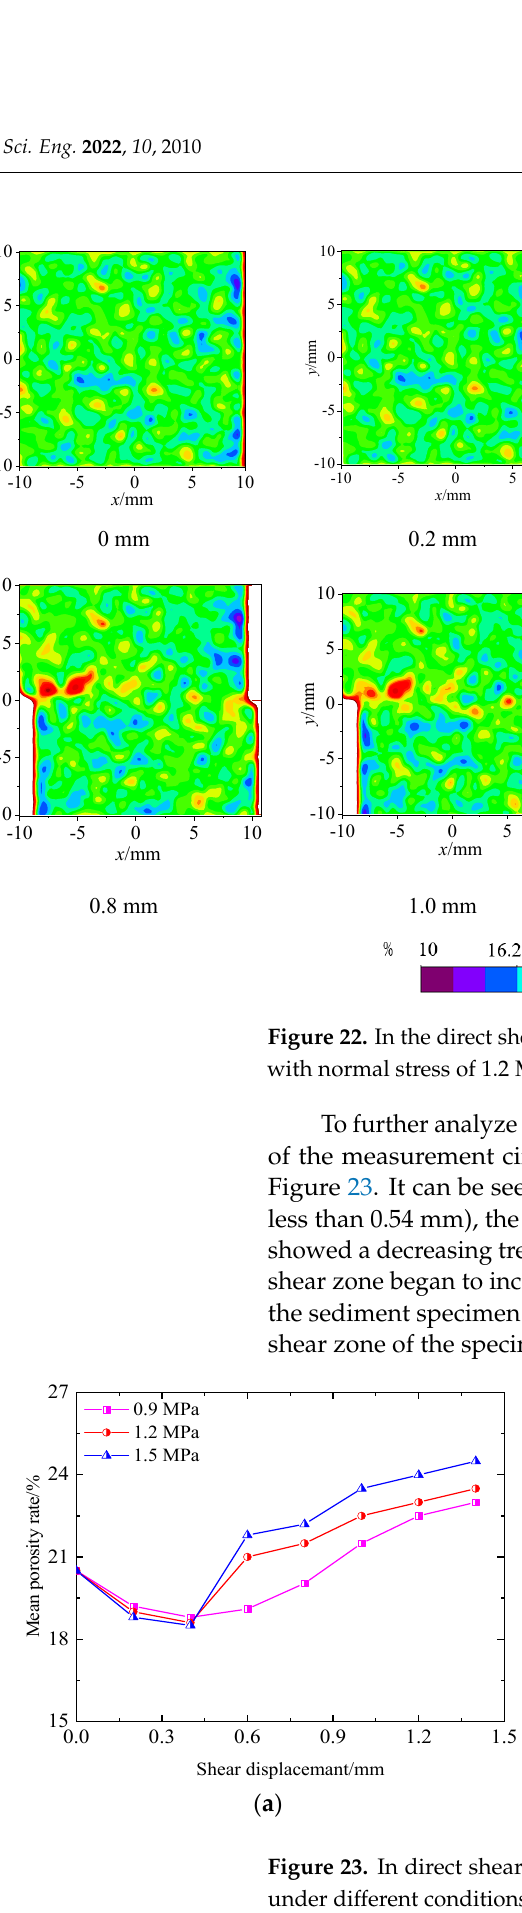
Figure 21. Schematic diagram of sample measurement circle layout in the direct shear test.